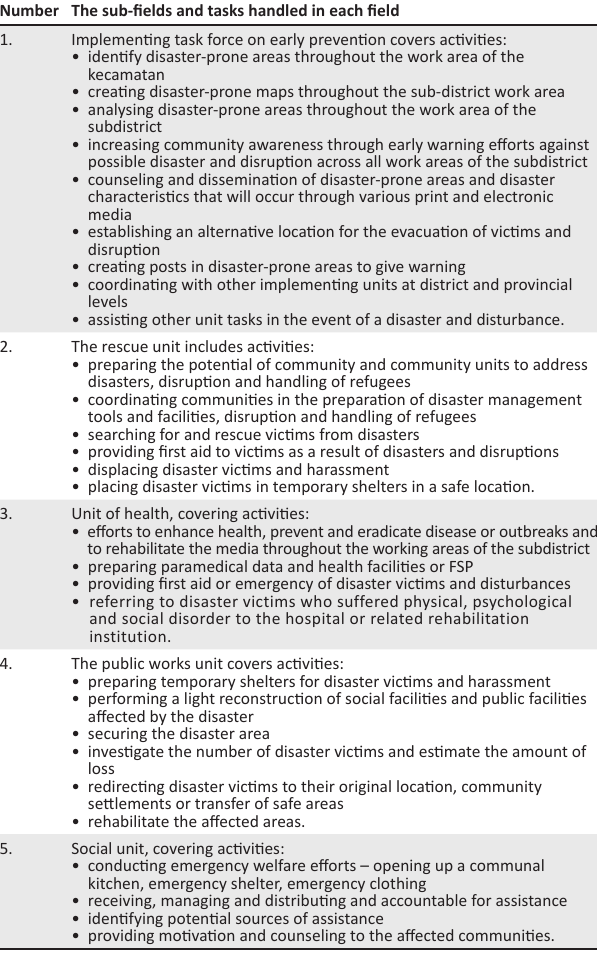
TABLE 5 : Duties of the community protection unit at the sub-district level. Number The sub-fields and tasks handled in each